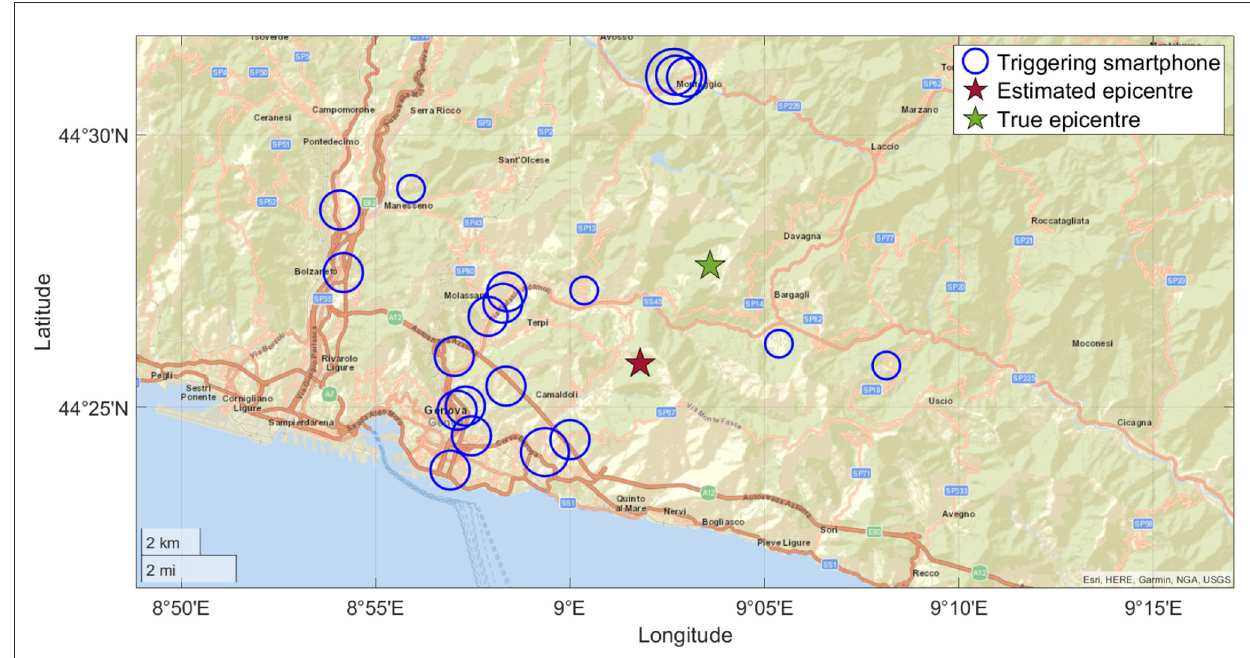
FIGURE5 EQN triggers for the earthquake occurred on 4 October 2022 close to Genoa (Italy). The diameter of circles is proportional to the triggering time.